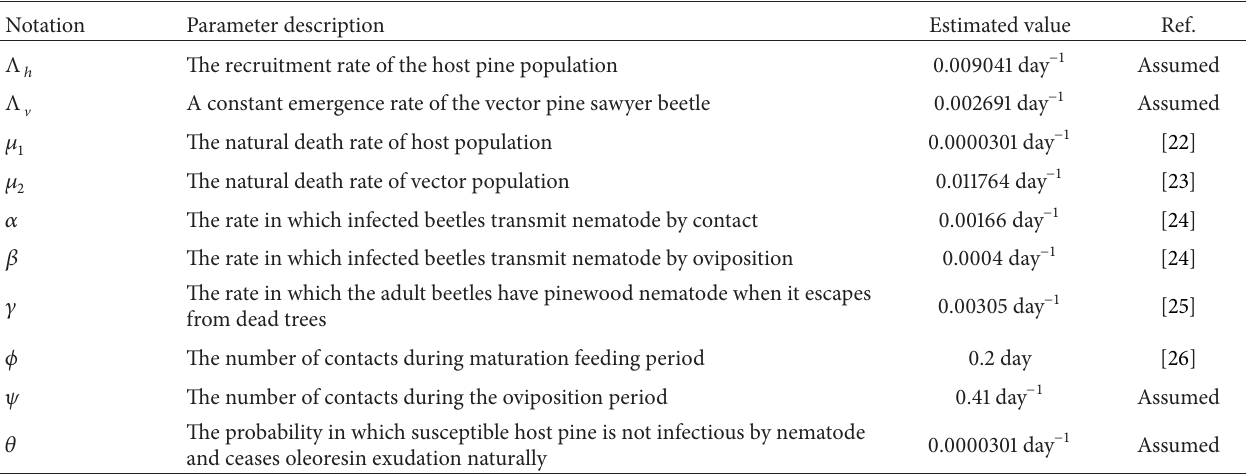
Table 1: Parameters used for numerical simulation.